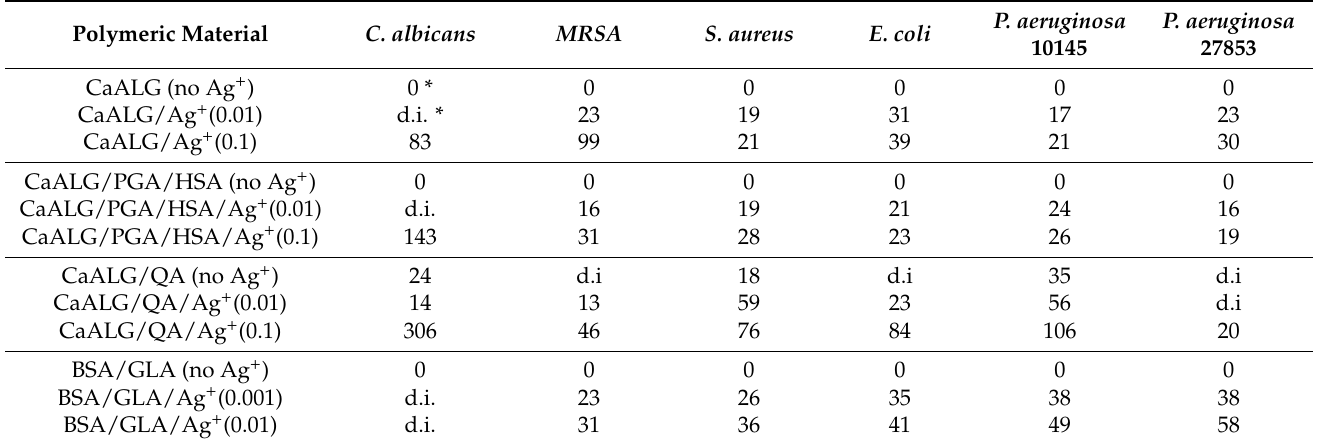
Figure 5. Concentration of Ag + ions released into aqueous 0.2 M NaNO 3 supporting electrolyte obtained using electrochemical determination from a BSA/GLA/Ag + (0.01) hydrogel disk over a 55 h period. The stripping peak currents were normalised with respect to deposition times and Ag + concentrations determined using the averaged normalised calibration curve parameters. Table 3. Antimicrobial growth inhibition zones (mm 2 )